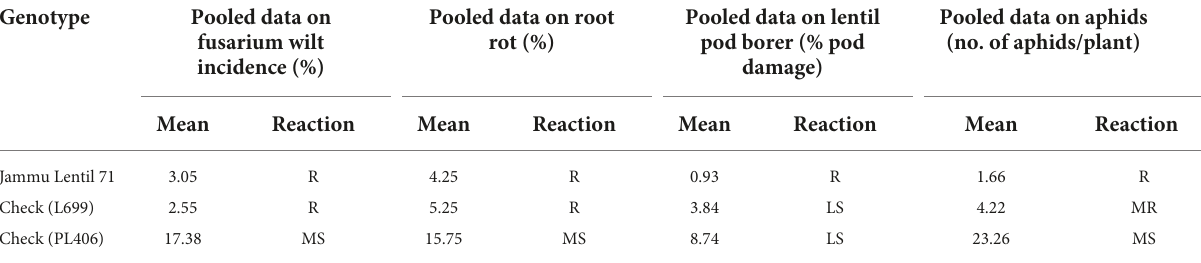
TABLE 7 Screening of selected derivative Jammu Lentil 71 against major biotic stresses during winter seasons of 2016–2017, 2017–2018, and 2018–2019.